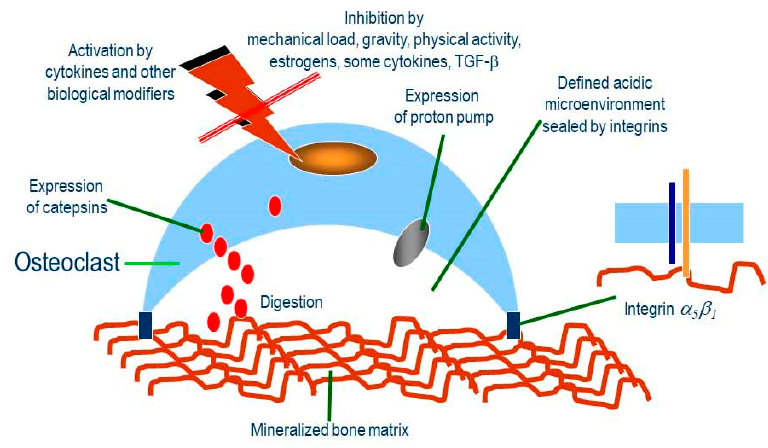
Figure 1. Role of osteoclasts in osteoporosis and the inhibiting e ff ects of mechanical load, gravity, and physical activity. Bone resorption is performed by osteoclasts when activated by certain cytokines, hormones, and the absence of mechanical stimulation (load, gravity, physical activity). In these conditions, cathepsins, H + -dependent plasmamembrane ATP-ase and α 5 β 1 integrin are expressed. The α 5 β 1 integrin interact with the extracellular matrix (ECM) molecules of the mineralized bone matrix, forming a segregated vacuole, where cathepsins and protons are secreted; cathepsins are activated by an acidic environment, demolishing mineralized matrix lining the segregated vacuole. Mechanical forces, including gravity, estrogen, TGF- β , and certain cytokine signalling, reduce or block the expression of integrin, proton pump, and cathepsin, preventing the digestion of the bone matrix. On the other hand, it is well known that absence of estrogen signalling (menopause), physical activity (sedentary life style), and gravity (microgravity) are conditions highly favouring osteoporosis. Strictly connected to the bone, skeletal muscle tissue is susceptible to mechanical input and is able to respond to the mechanical stretch. In fact, these stimuli can modulate a differentiation or proliferation of the muscle cells [41,42].